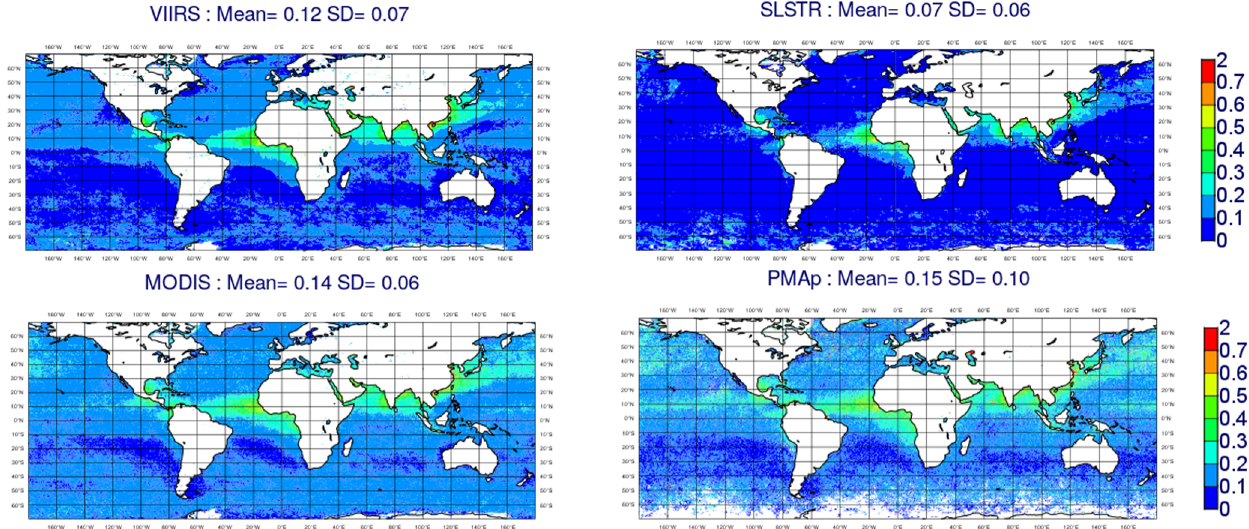
Figure 3. Global maps of temporal mean AOD from Terra and Aqua/MODIS, NOAA20 and SNPP/VIIRS, S3A and S3B/SLSTR, and MetOp-A/B–PMAp for the MAM (2020) period over ocean.